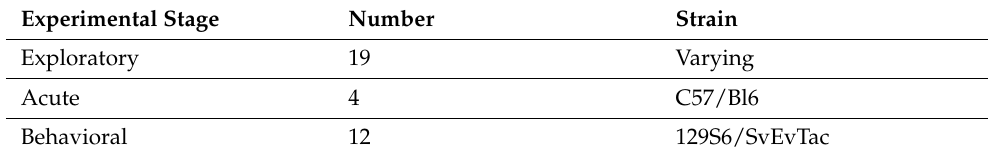
Table 1. Description of mice used for various stages of the study. Experimental